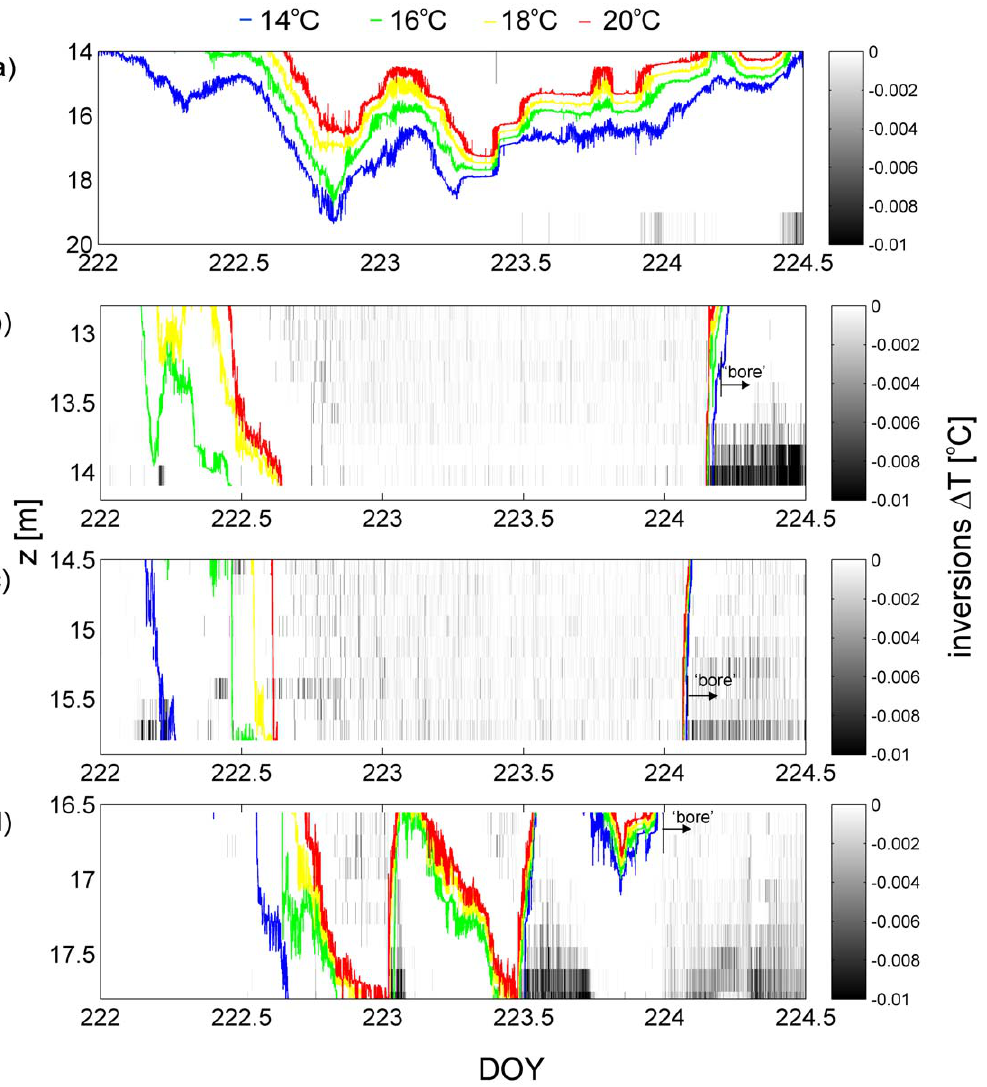
Figure 5. Relation between local isotherm movements and temperature inversions. Data are shown at the four thermistor chains during and after a strong storm event between DOY 222 and 225 at a) C1. b) T1. c) T2. d) T3. The blue, green, yellow and red lines denote the position of the local 14 u C, 16 u C, 18 u C and 20 u C isotherm at each site. The position of the cold water front (bore) is based upon the steep temperature gradients in Figure 3e–3g which show the upslope flow of a cold bore into shallower waters. The arrival of the bore is represented by rapid cooling (steep gradient of the isotherms) followed by the onset of temperature inversions.